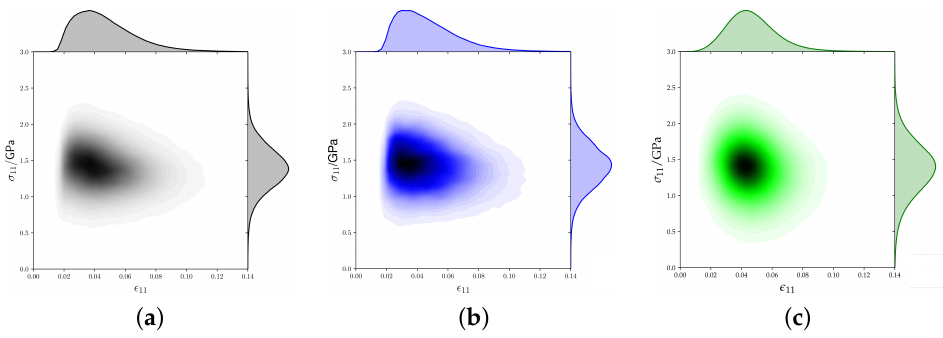
Figure 7. Heatmaps showing stress versus strain distributions in Rolling Direction (RD). ( a ) Measured microstructure. ( b ) 2D Representative Volume Element (RVE). ( c ) 3D